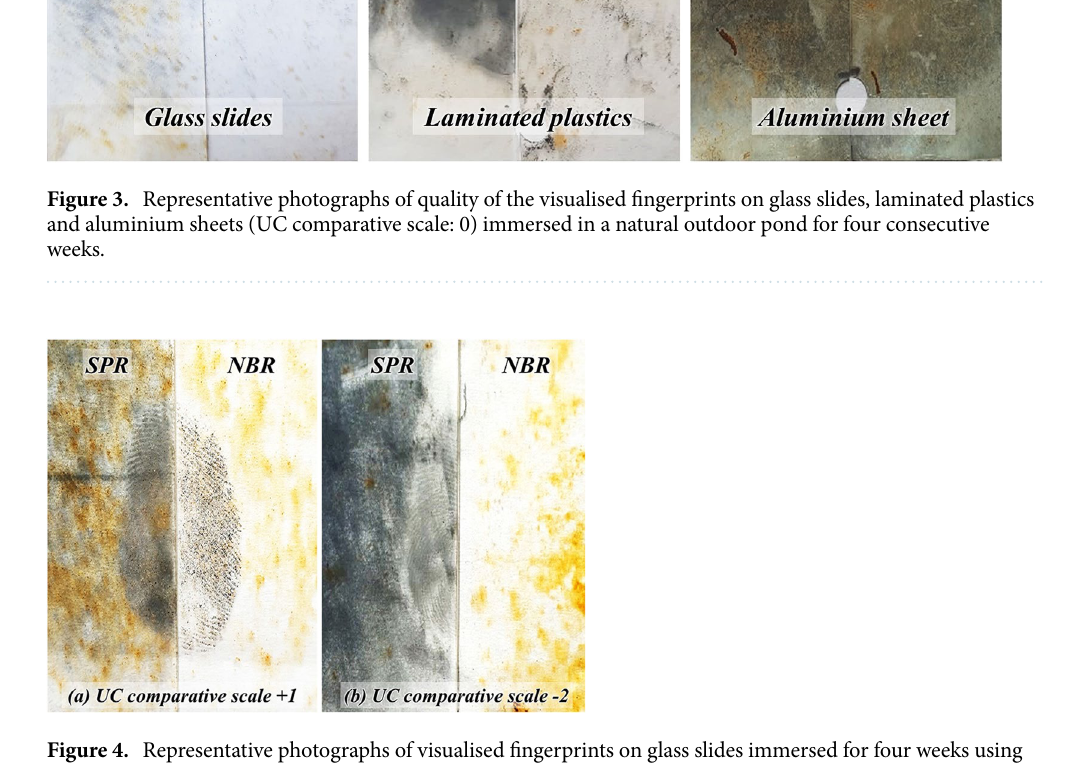
Figure 4. Representative photographs of visualised fingerprints on glass slides immersed for four weeks using both SPR (left) and NBR (right). The sets of split visualised fingerprint depict UC comparative scale of ( a ) + 1 and ( b ) −